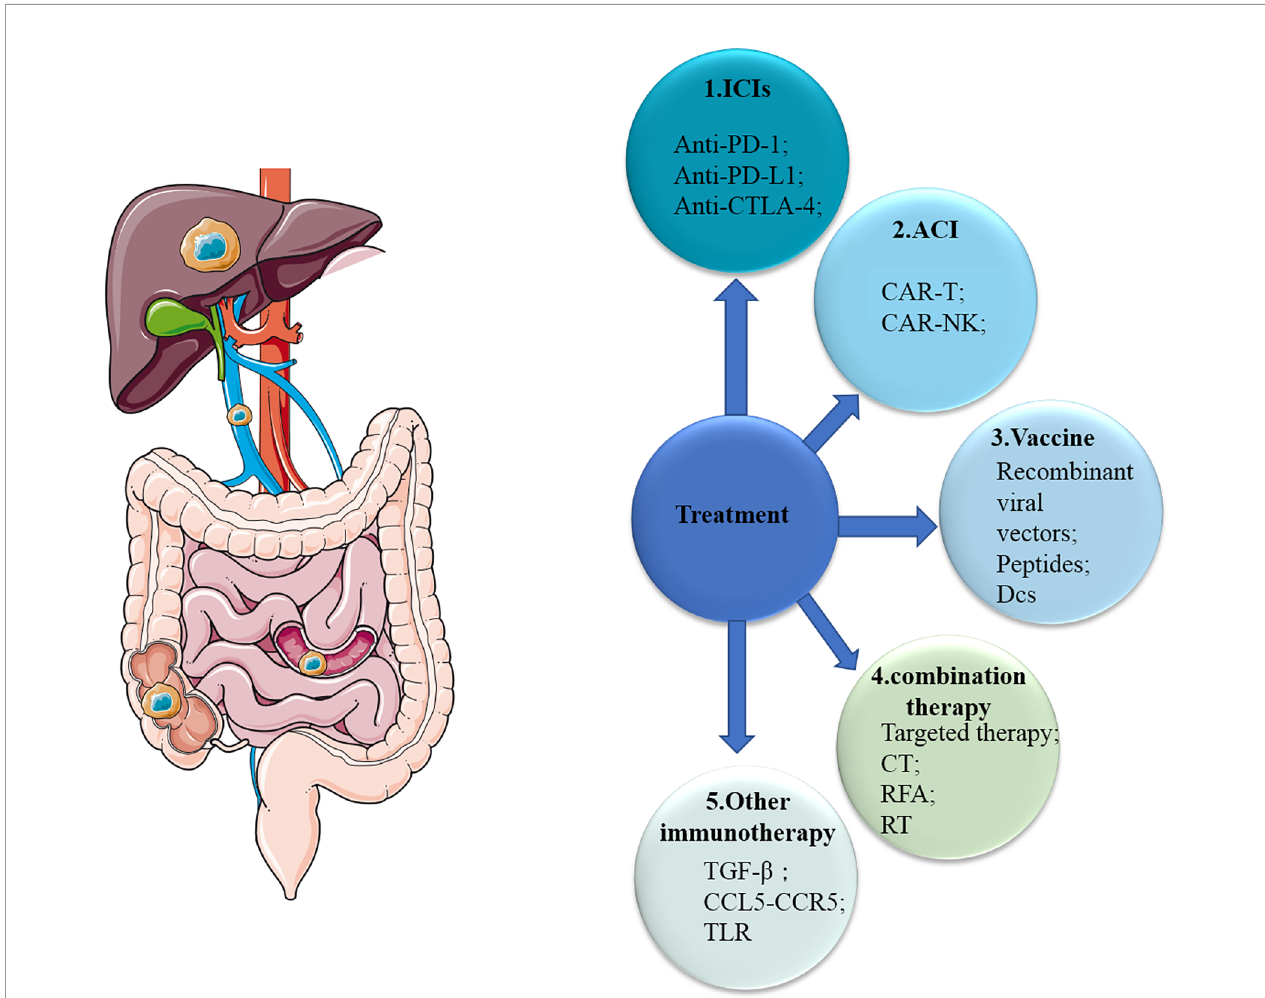
FIGURE 3 | Overview of therapies for mCRC. mCRC, metastatic colorectal cancer; ICIs, immune checkpoint inhibitors; ACI, adoptive cellular immunotherapy; CT, chemotherapy; RFA, radiofrequency ablation; RT, radiotherapy; CTLA-4, cytotoxic T-lymphocyte-associated protein 4; PD-1, programmed cell death 1; PD-L1, PD-1 ligand; Treg, regulatory T cell; DC, dendritic cell; NK cell, natural killer cell; TLR, toll-like